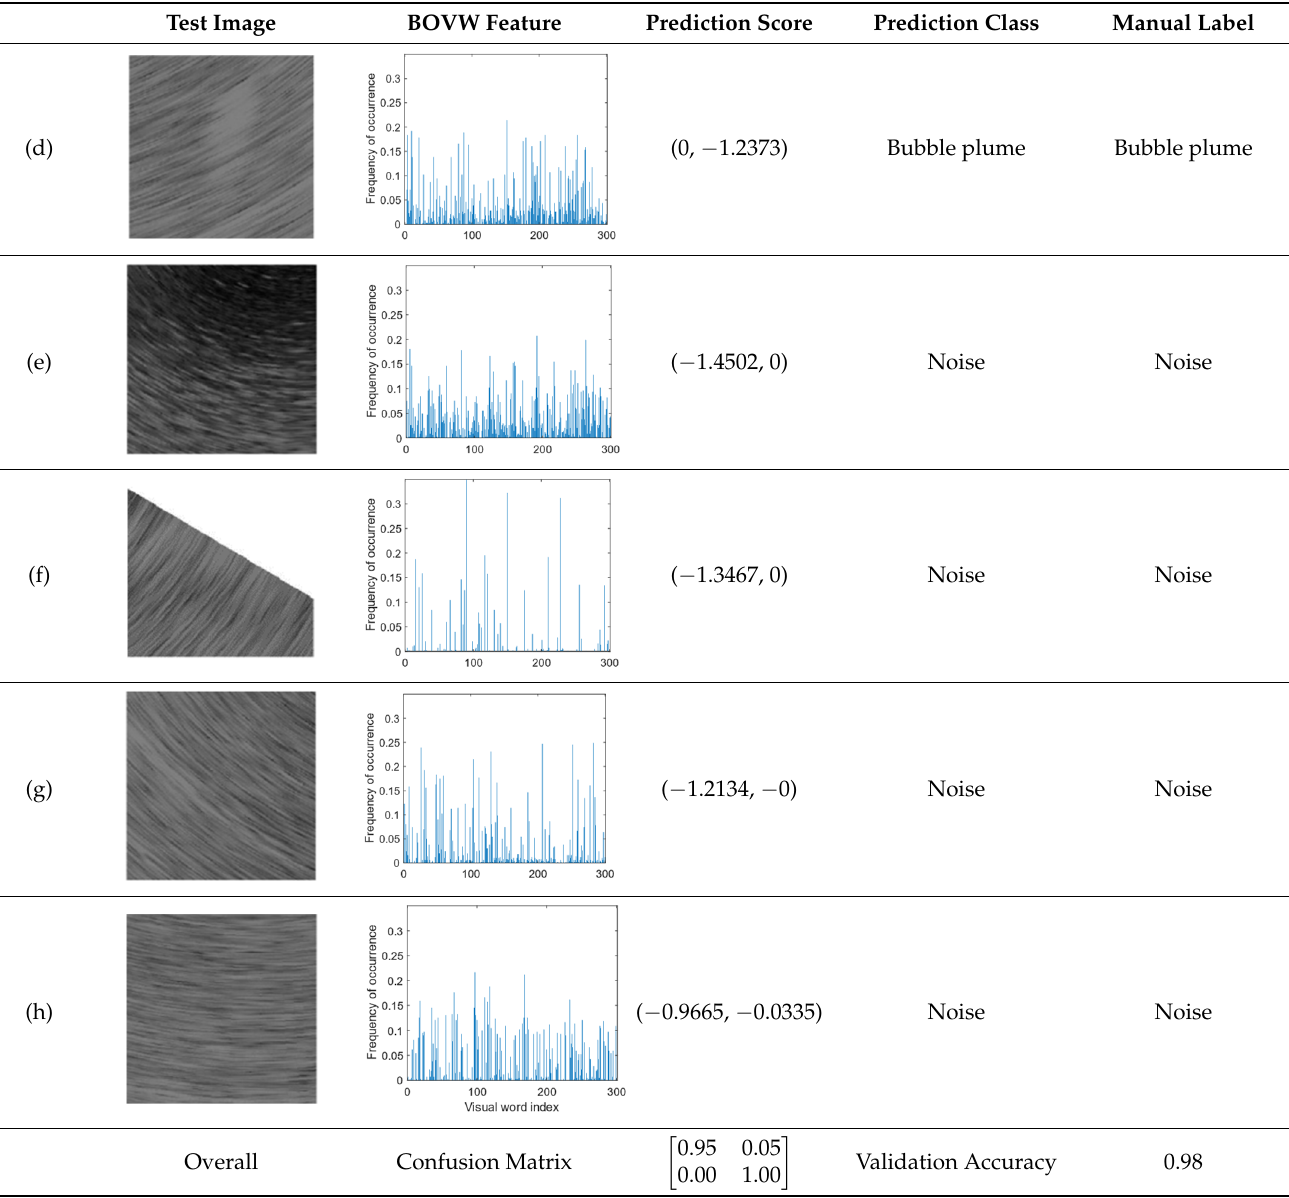
Figure 13. Target detection results using fix anchor boxes ( a ) and moving anchor boxes ( b ). ( c ) is the maximum boundary of ( b ). Detected